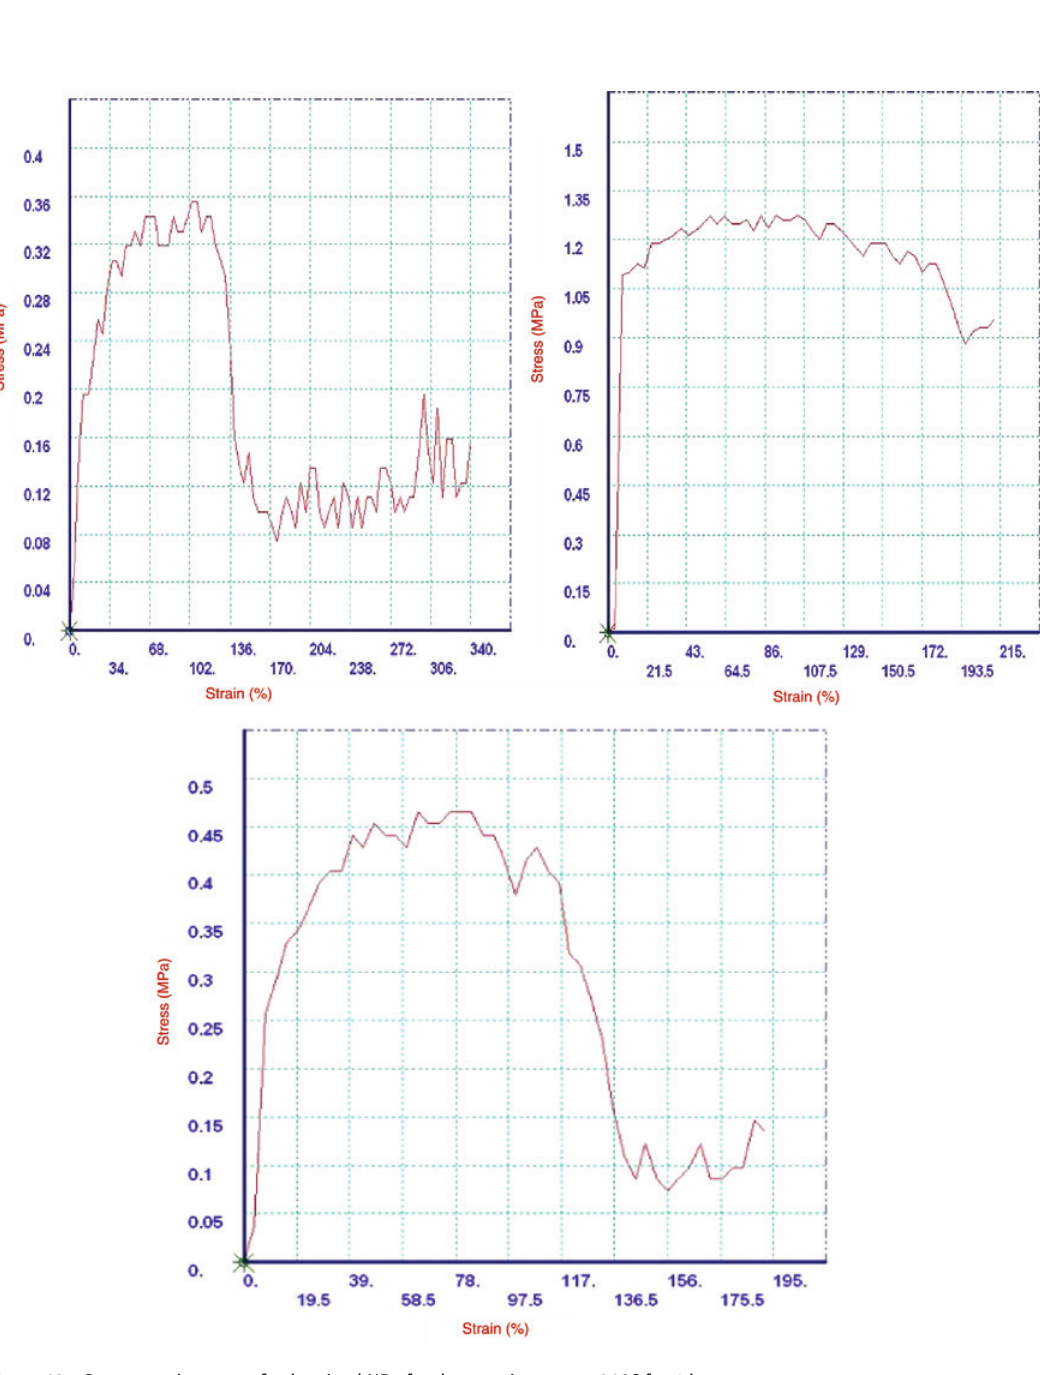
Figure 10: Stress-strain curve of vulcanized NR after heat resistance at 80 ° C for 4